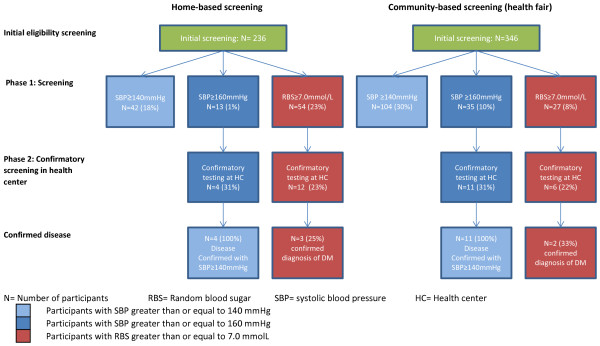
Flow chart for screening results in home- and community-based screening.